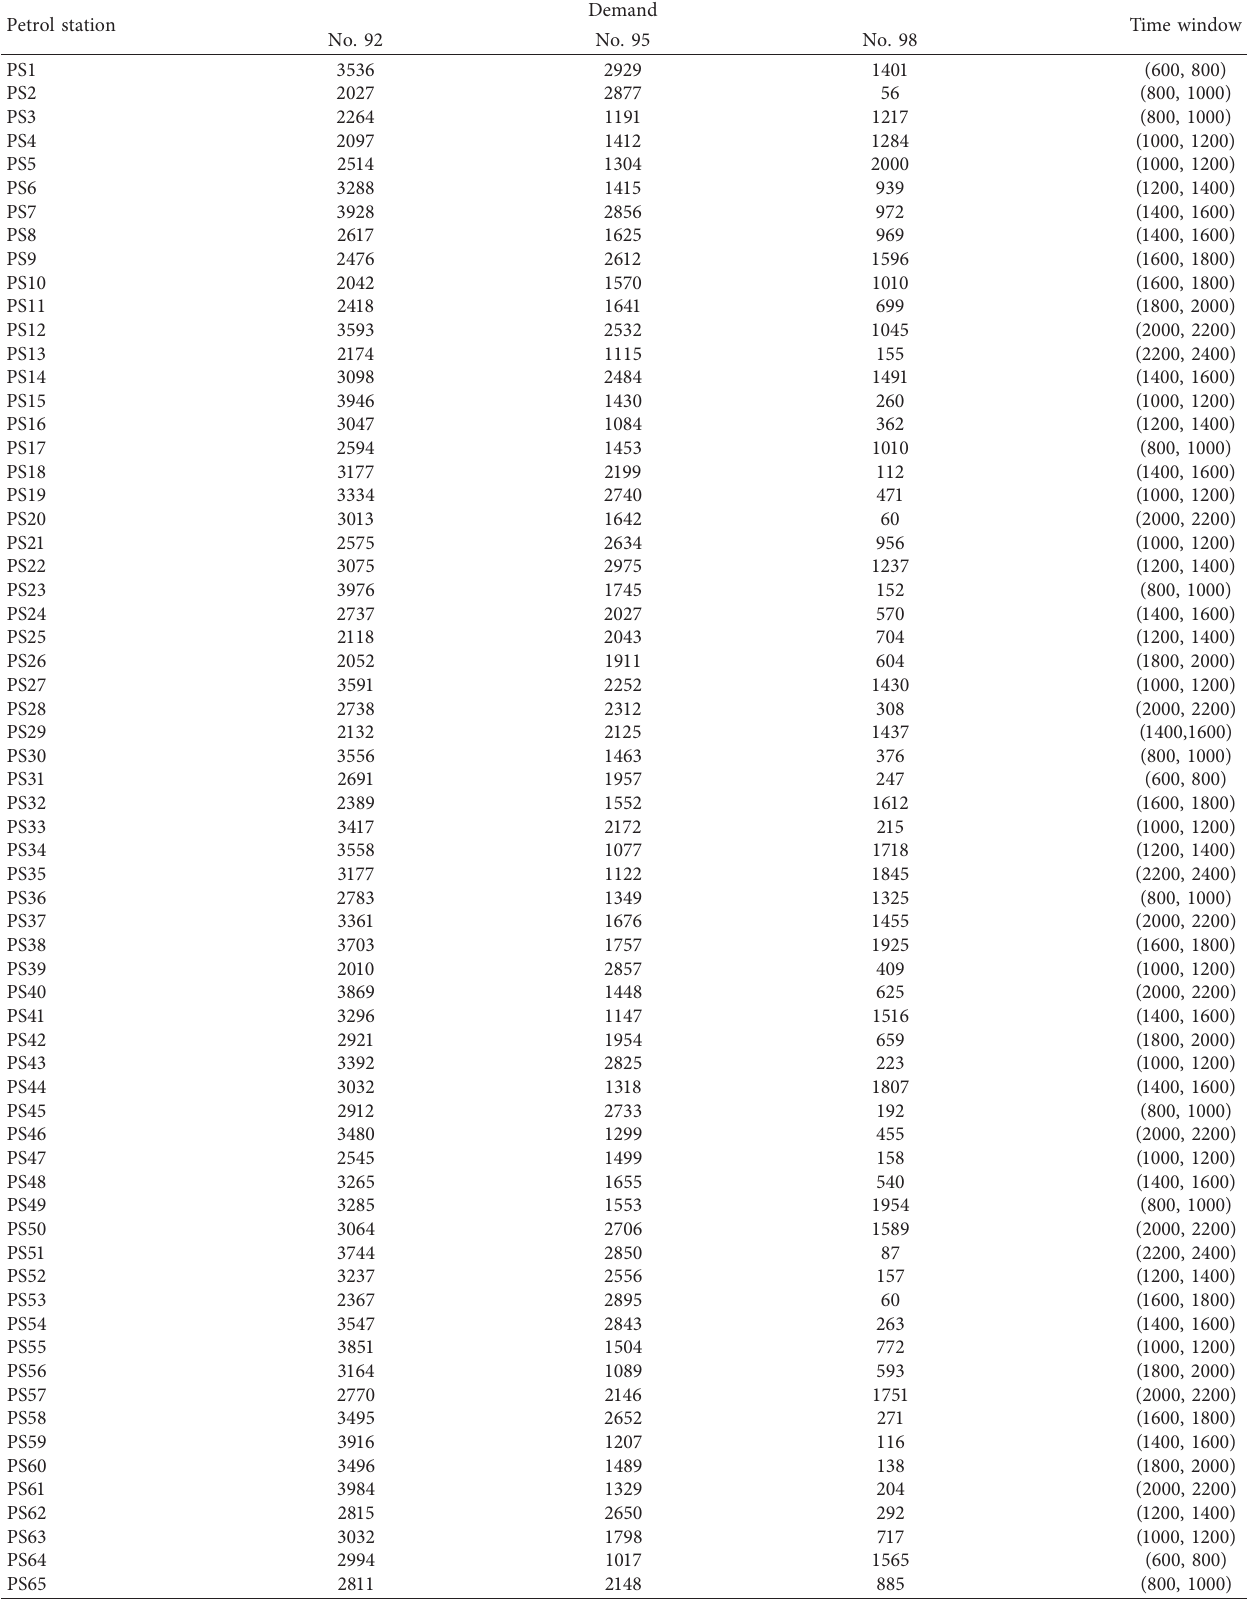
Table 5: The demand quantity and service time window of each petrol station in a time period